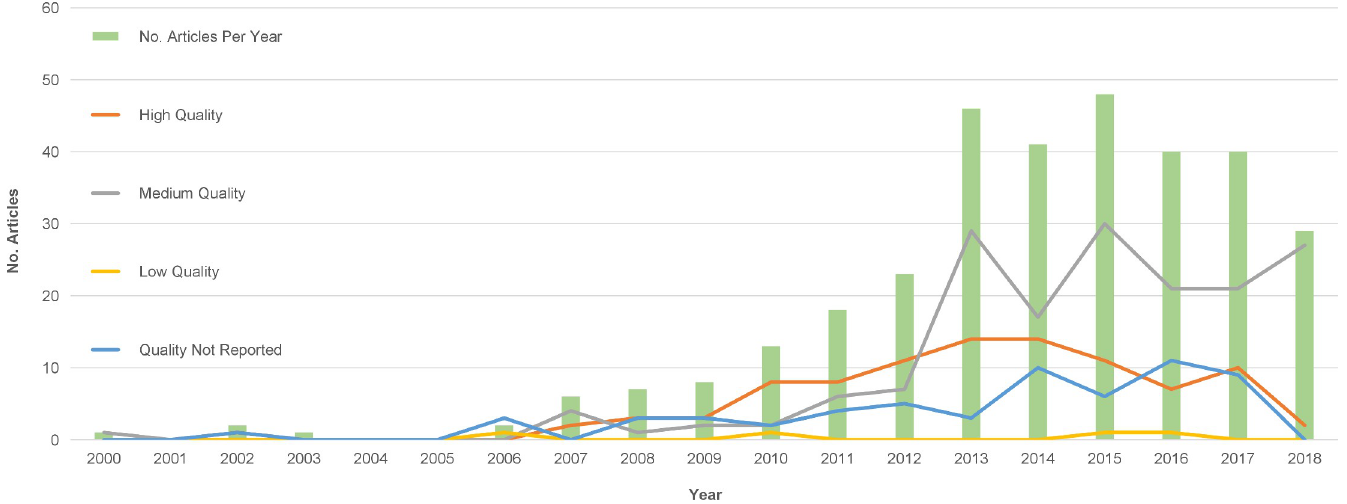
Fig 3. Number of articles published per year and by quality of publication.